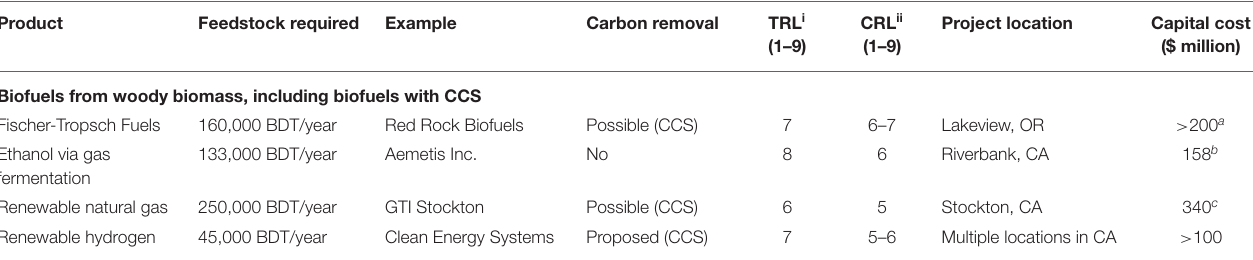
TABLE 1 | Characterization of low-carbon and carbon-negative pathways proposed in